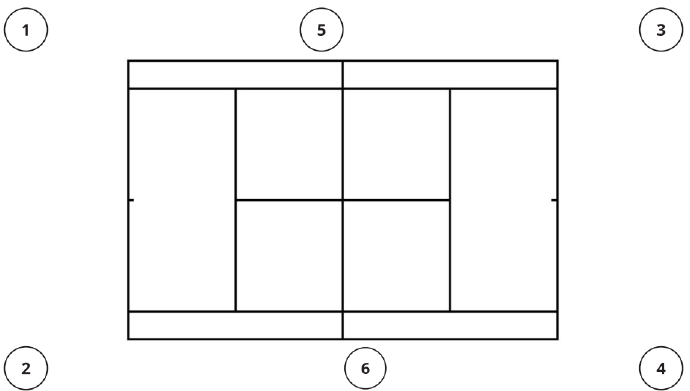
Figure 1. A visual representation of the ball kid’s court positions, with positions 1, 2, 3, and 4 repre- senting back court positions and positions 5 and 6 representing net positions.